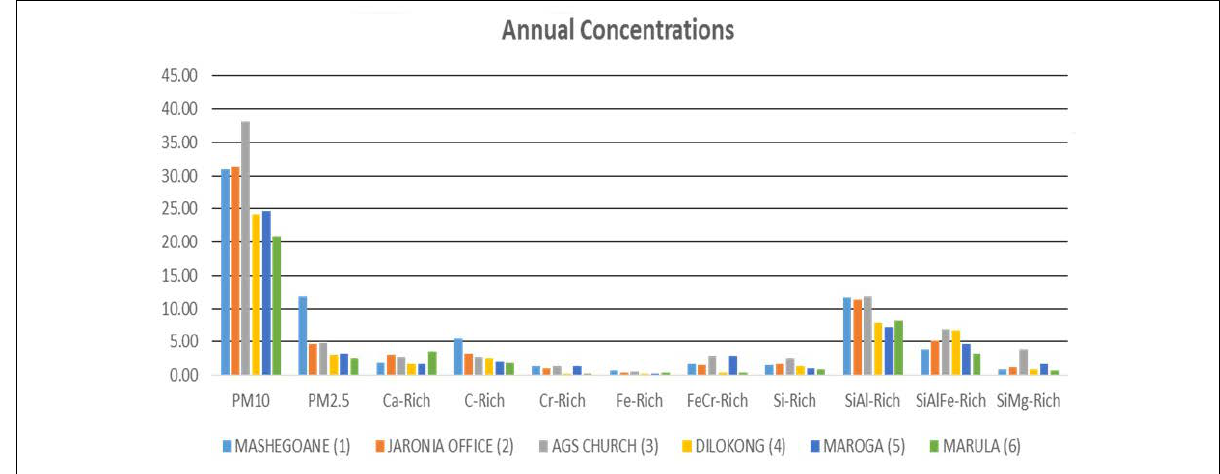
, PM and PM chemical components (site number in 10 2.5